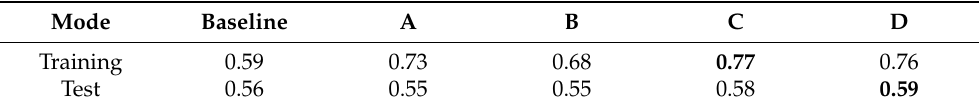
Figure 25. Compared results of IoU scores in the respective classes: Training dataset ( left ) and Test dataset ( right ). Table 23. Compared results of mIoU scores in Soybeans experiments (Bold values show maximum